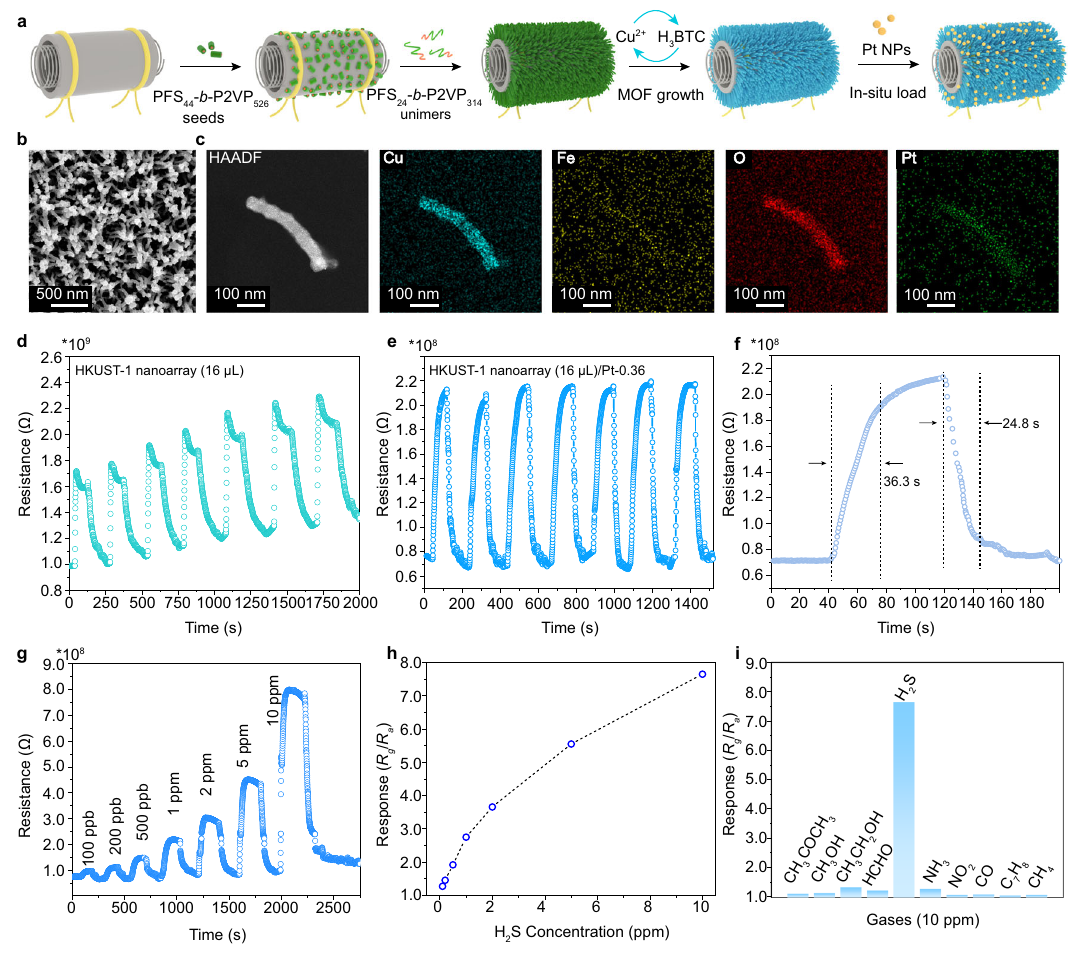
Fig. 6 | Fabrication of HKUST-1 nanoarrays on ceramic tubes and their gas sensing performance. a Schematic illustration of the fabrication process of HKUST-1 nanoarray on a ceramic tube and the further loading of Pt nanoparticles. b SEM image of the HKUST-1 nanoarray (16 µ L)/Pt-0.36. c HRTEM image and ele- ment mapping of the HKUST-1 nanoarray (16 µ L)/Pt-0.36. d Repeating response- recoverycurveofthepristineHKUST-1nanoarray(16 µ L)to1ppmofH 2 Sat200°C. e Repeating response-recovery curve of the HKUST-1 nanoarray (16 µ L)/Pt-0.36 to